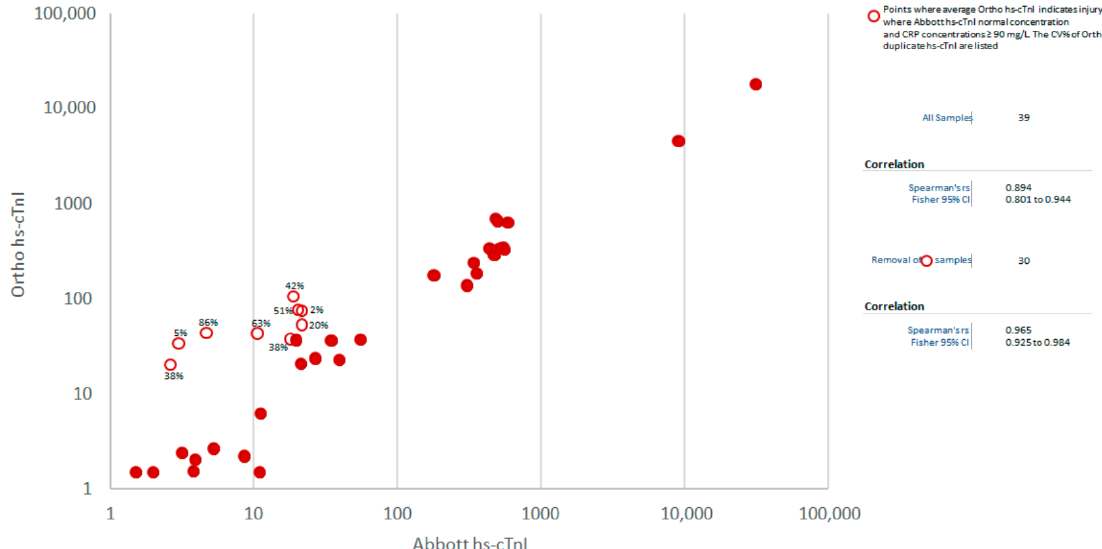
Figure 3. Correlation between Ortho hs-cTnI (average concentration) versus Abbott hs-cTnI in EDTA plasma samples. The open red circles represent samples that yielded concentrations that were indicative of injury for Ortho hs-cTnI and normal for Abbott hs-cTnI. The coefficients of variation (CVs) of the Ortho duplicate hs-cTnI results are listed for the open red circles (i.e., the discordant Ortho hs-cTnI